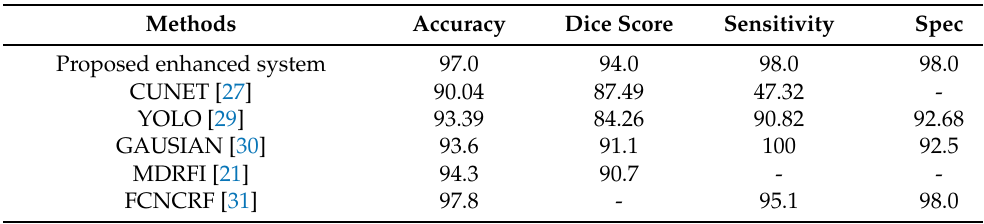
Table 4. Performance analysis (%) and comparison of the proposed method with existing probability based methods on the ISBI 2017